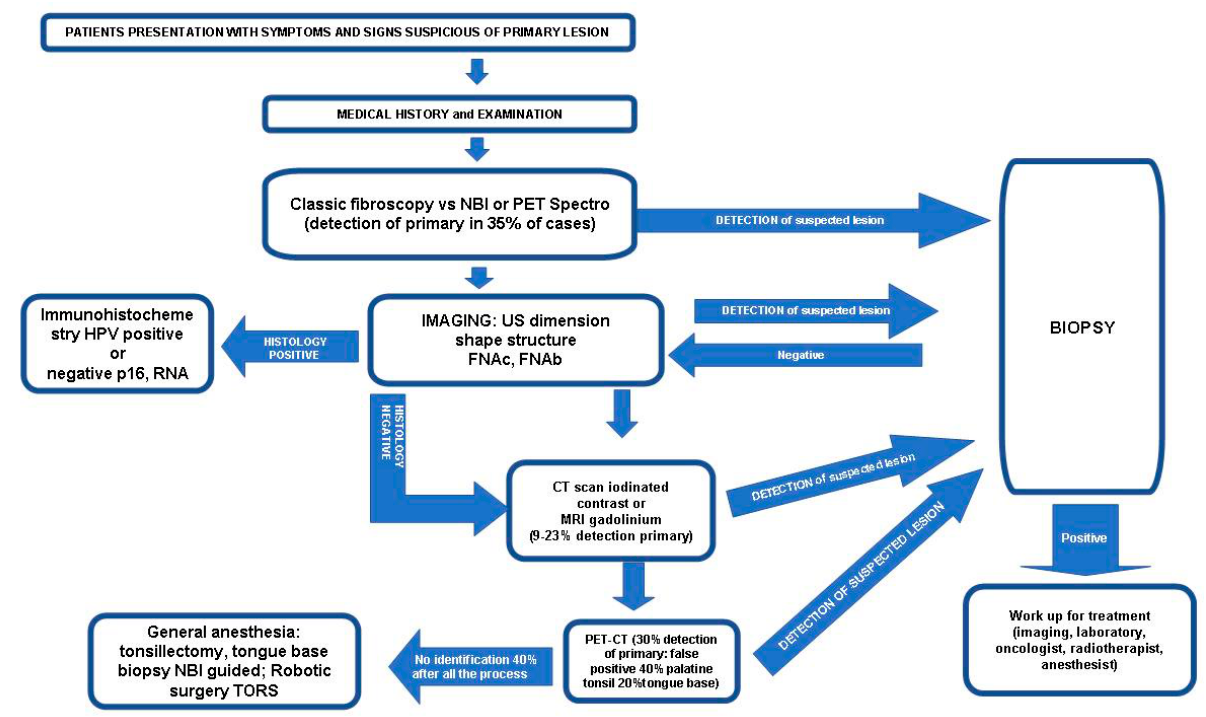
Figure 1. Oropharyngeal primary unknown cancer diagnostic work-up flow chart.